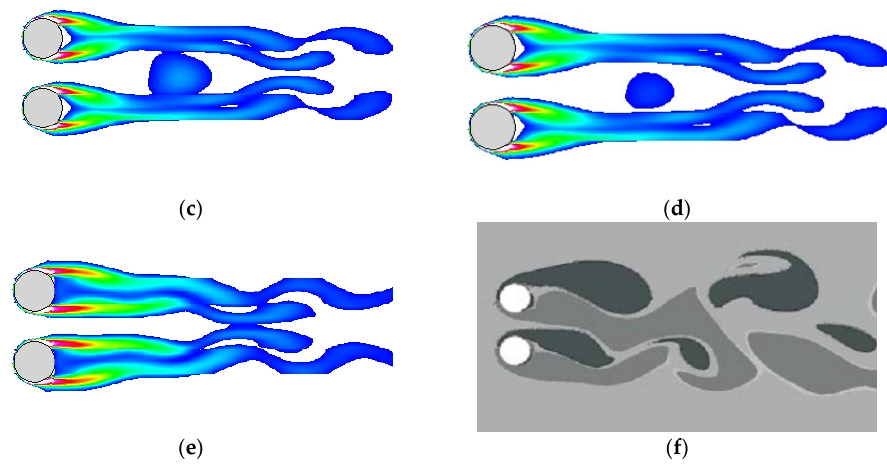
Figure 10. Development of vortex shedding at G/D = 8.0 and T/D = 1.75: ( a ) on the free surface; ( b ) instantaneous vorticity on a free surface of a single cylinder (Kawamura et al., 2002); ( c ) Z = 0.031; ( d ) Z = 0.03; ( e ) Z = 0.022; and ( f ) vortex formation of two rigid cylinders for T/D = 1.80 (Liu et al.,